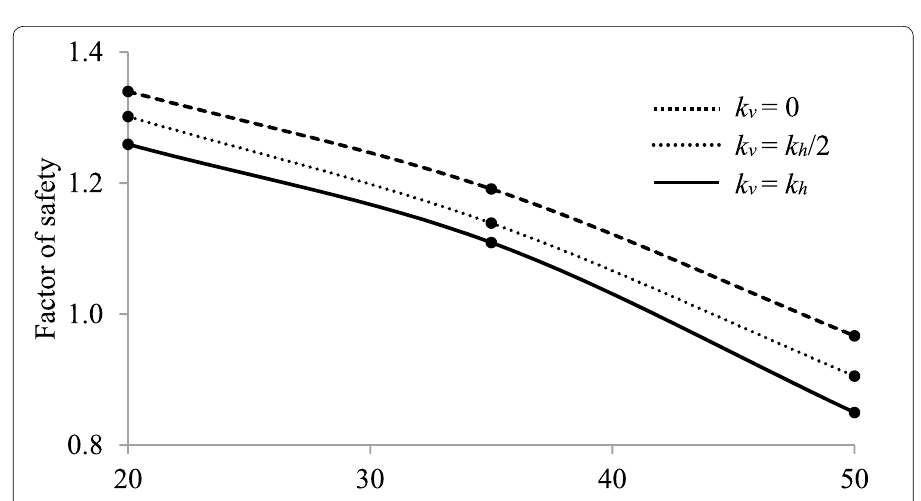
Fig. 5 Variations of factor of safety with k v for k h